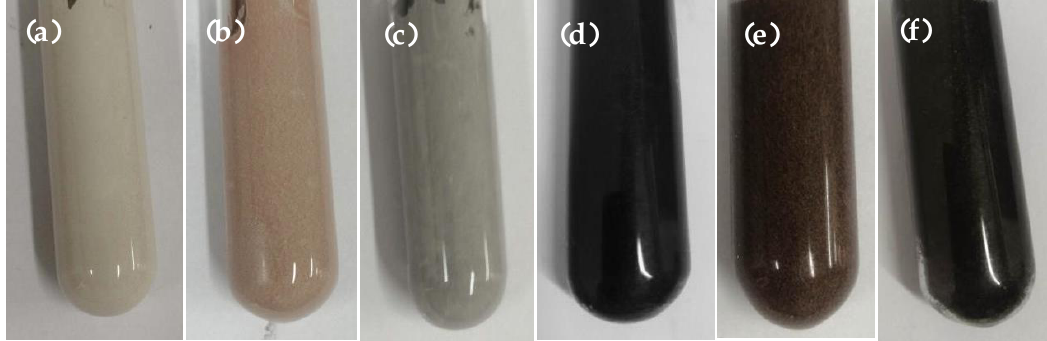
Figure 5. TSG with different types of fillers. ( a ) AIN:CP = 5:1. ( b ) AIN:CP = 1:5. ( c ) AIN:CF = 5:1. ( d ) AIN:CF = 1:5. ( e ) CP:CF = 5:1. ( f ) CP:CF = 1:5.